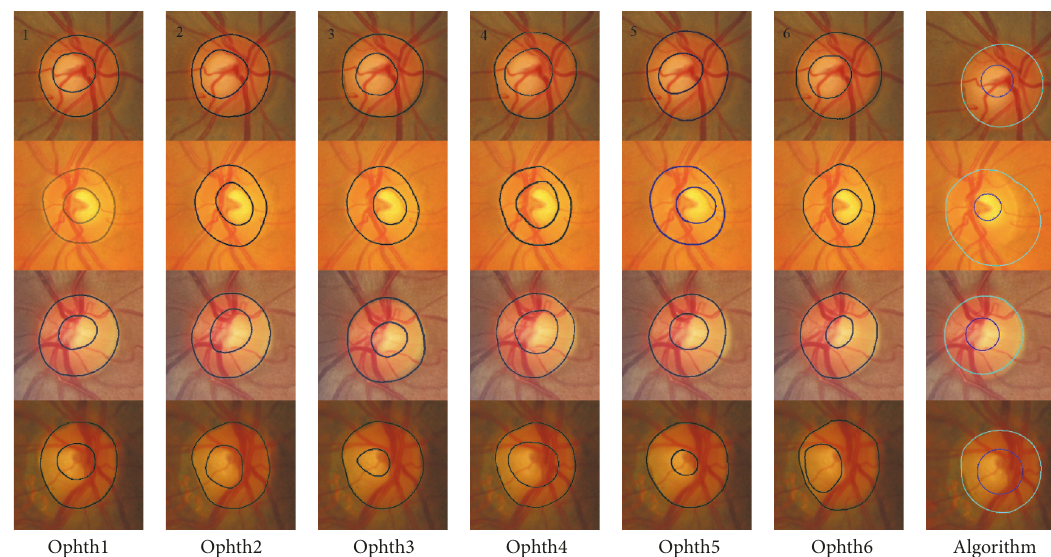
Figure 8: Examples of poor segmentation results for vertical cup to disc ratio. Each row shows the results for a sample image. The images on each row show the results of manual markings by the six ophthalmologists (1 to 6; left to right) and the automatic marking by the algorithm (far right).